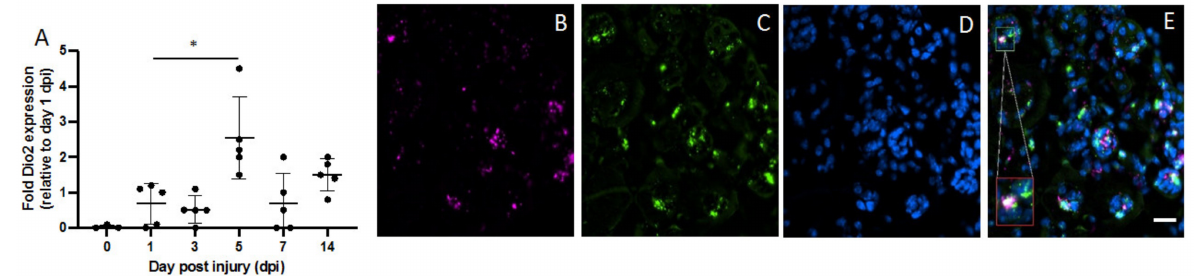
Figure 2. Dio2 and its presence in stem cells. ( A ) Augmented expression of Dio2 in isolated Pax7 + stem cells between days 1 and 14 after injury measured by RT-PCR. In situ hybridization on day 5 after injury showing Dio2 mRNA stained in pink ( B ) and Pax7 + cells in green ( C ) and DAPI in blue ( D ). ( E ) Colocalization of Dio2 in Pax7 + cells. * p = 0.0001. Data are expressed as the mean ± SEM. Images are representative of injury in one of five different mice analyzed ( n = 5). Scale bar = 50 µ m.